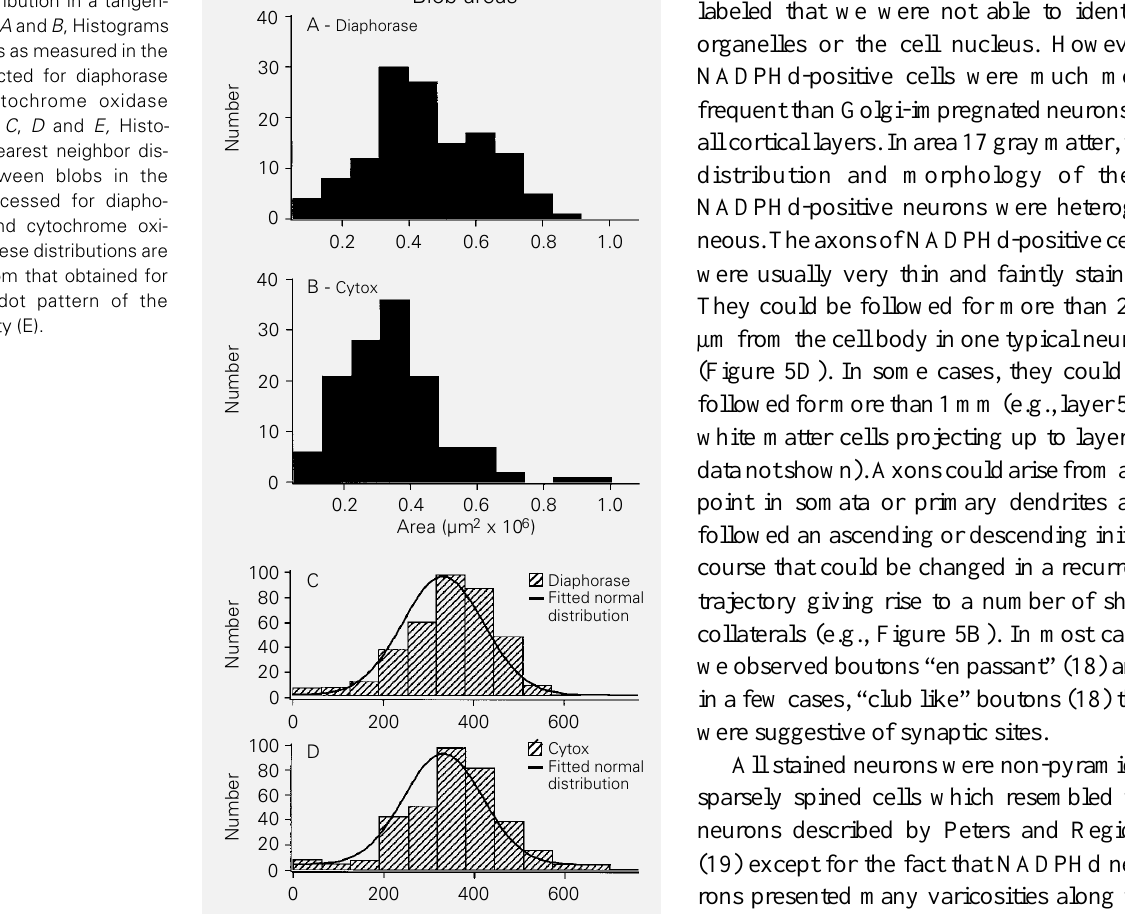
Figure 3 - Quantitative analysis of blob distribution in a tangen- tial section. A and B , Histograms of blob areas as measured in the section reacted for diaphorase (A) and cytochrome oxidase (Cytox) (B). C , D and E, Histo- grams of nearest neighbor dis- tances between blobs in the section processed for diapho- rase (C), and cytochrome oxi- dase (D). These distributions are different from that obtained for a random dot pattern of the same density